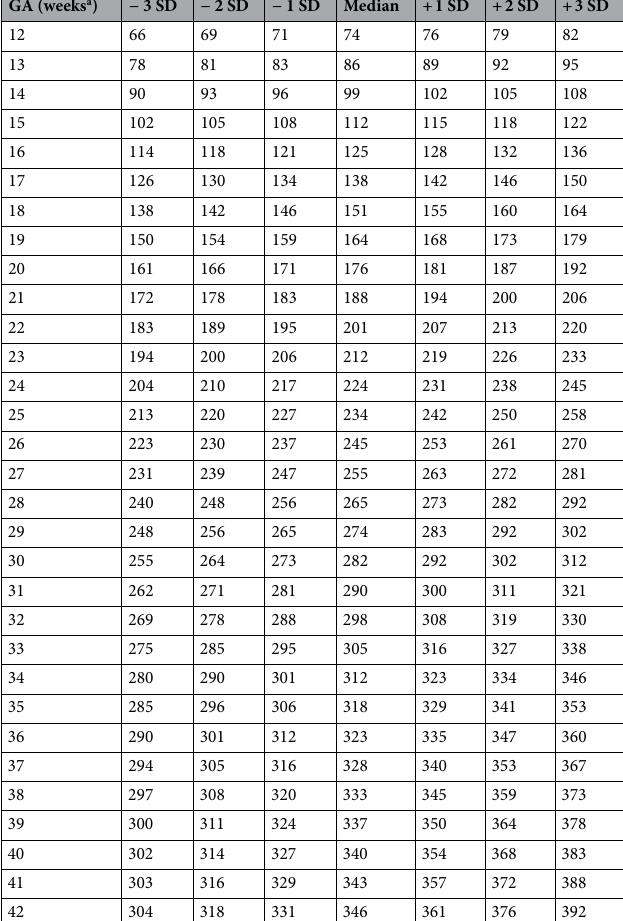
Table 4. Estimated head circumference (HC) in mm by gestational age (GA) for males and females, standard deviations (SD). a GA expressed as completed gestational weeks, e.g. 12 weeks corresponds to 12 + 0 weeks or 84 gestational